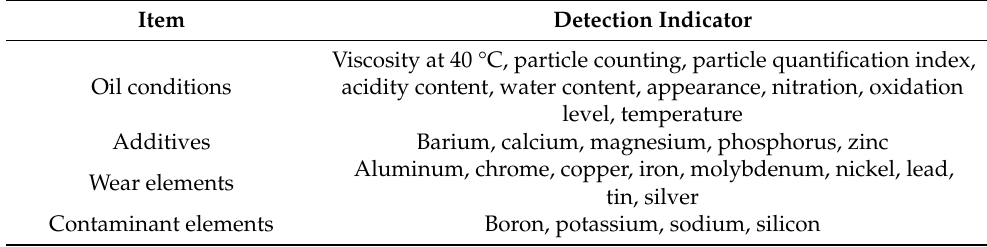
Table 3. Parameters for gearbox oil analysis